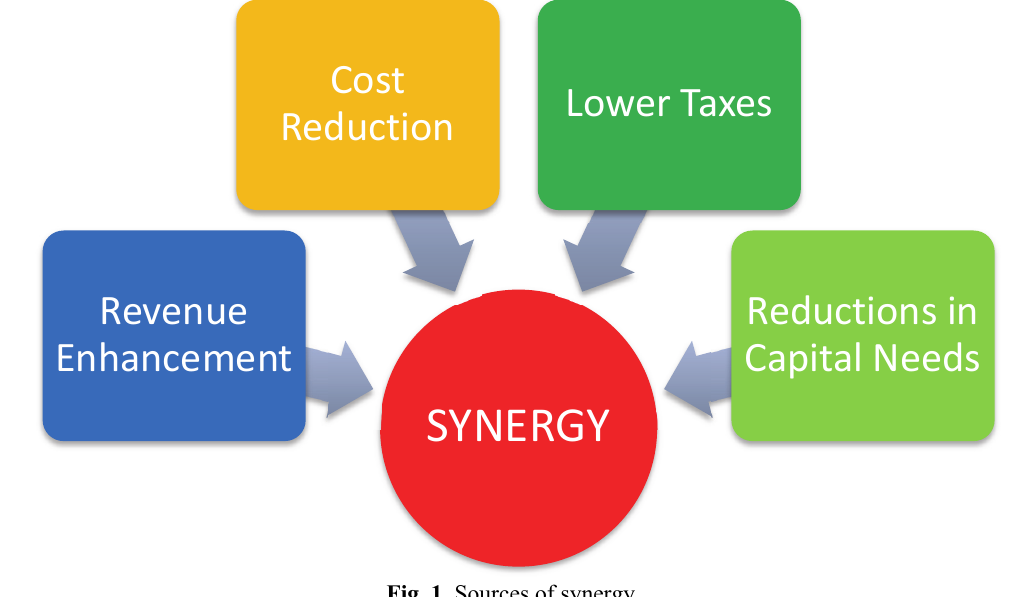
Fig. 1. Sources of